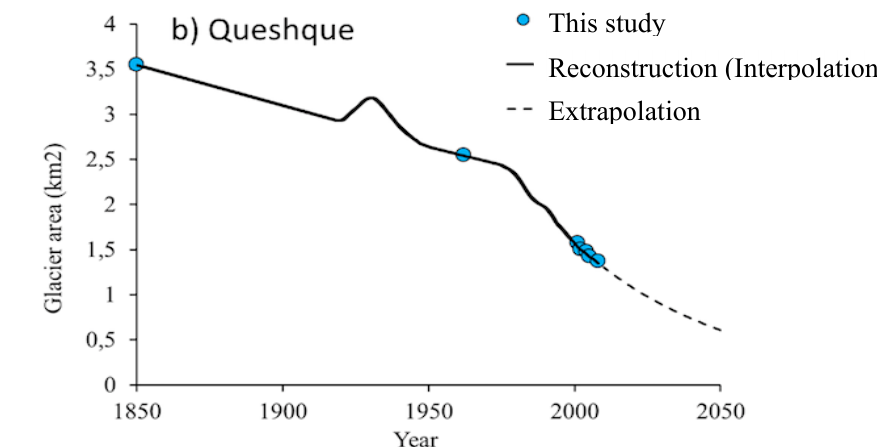
Figure 13. The change in surface area of QUE. Data of 1850 AD (blue dot in 1850 AD) are the results of the CA model. The change in glacier surface area was measured from aerial photos (blue dot on 12 June 1962) and the series of ASTER imagery (blue dots during 2001–2008 AD)[65], and the thick black line represents the interpolation of the change in glacier extent. The information of the glacier re-advance (late 1920s to early1930s) is included in the interpolation [65].